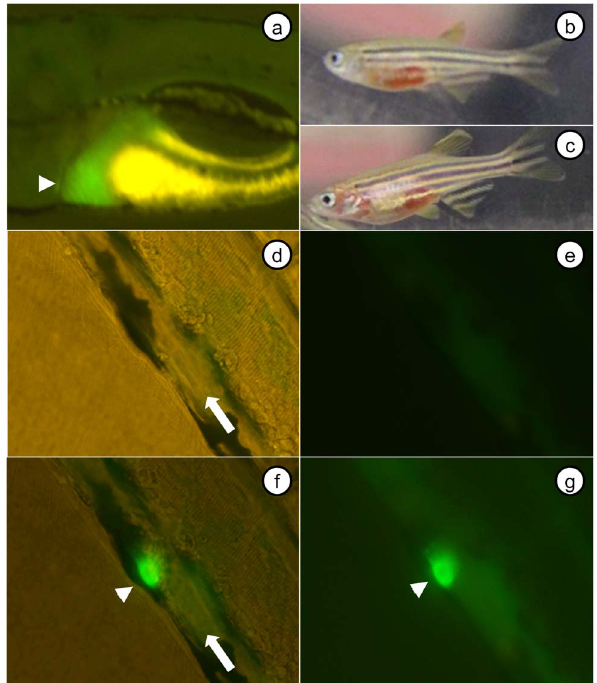
Figure 2. Liver specific expression of fgb-egfp results in incorporation of fusion protein into an induced thrombus. A fabp10-fgb-egfp transgenic line of zebrafish was produced, and F1 offspring analyzed. (a) Expression was liver specific, as demonstrated by the region of green fluorescence in a 5 dpf larva (yellow signal is yolk sac autofluorescence). (b, c) F1 adult fish displayed overt hemorrhage, suggestive of potential interference with coagulation secondary to dysfibrinogenemia. Pictures of the PCV prior to (d, brightfield + fluores- cence; e, fluorescence only), and after (f, brightfield + fluorescence; g, fluorescence only) laser injury (f, g were prior to complete occlusion). The arrowhead in a indicates liver, arrows in d, f indicate PCV and direction of flow, and arrowheads in f, g point to the induced